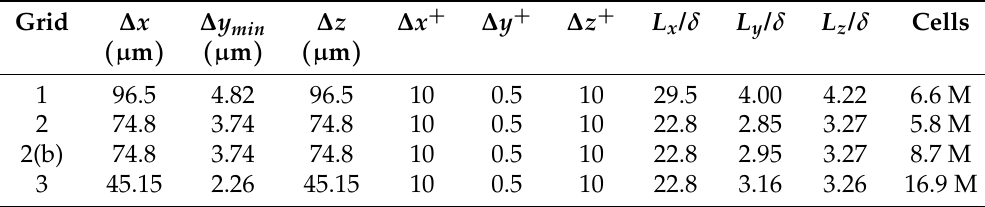
Table 2. Grid Properties for the Slightly Cold Wall Flat Plate.